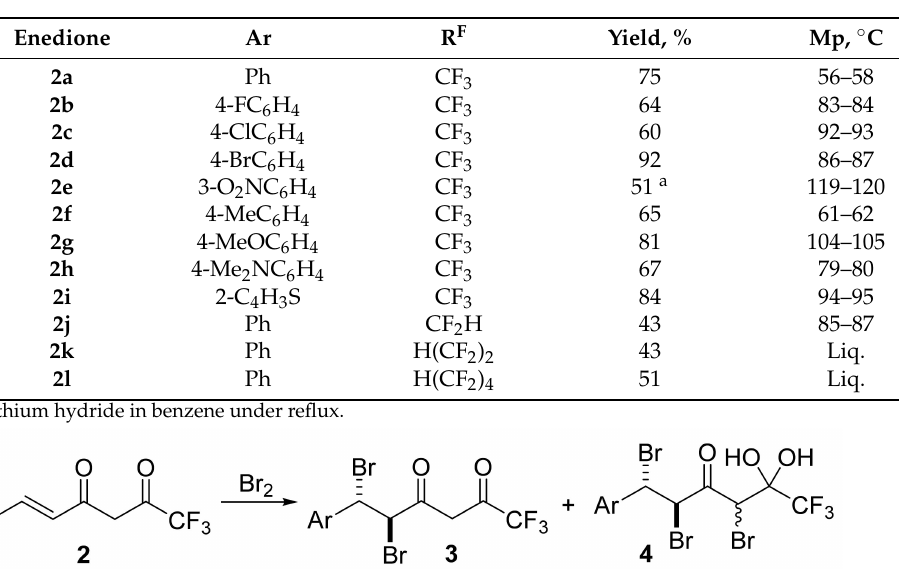
Table 1. The scope of prepared enediones 2 .